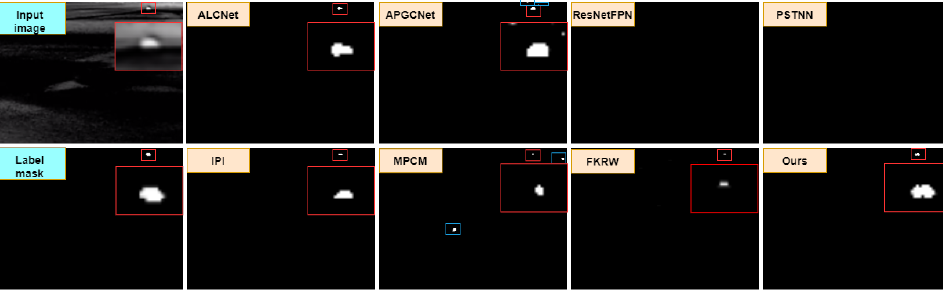
Figure 10. Detection results of infrared small targets in Scene 3 using different detection methods.